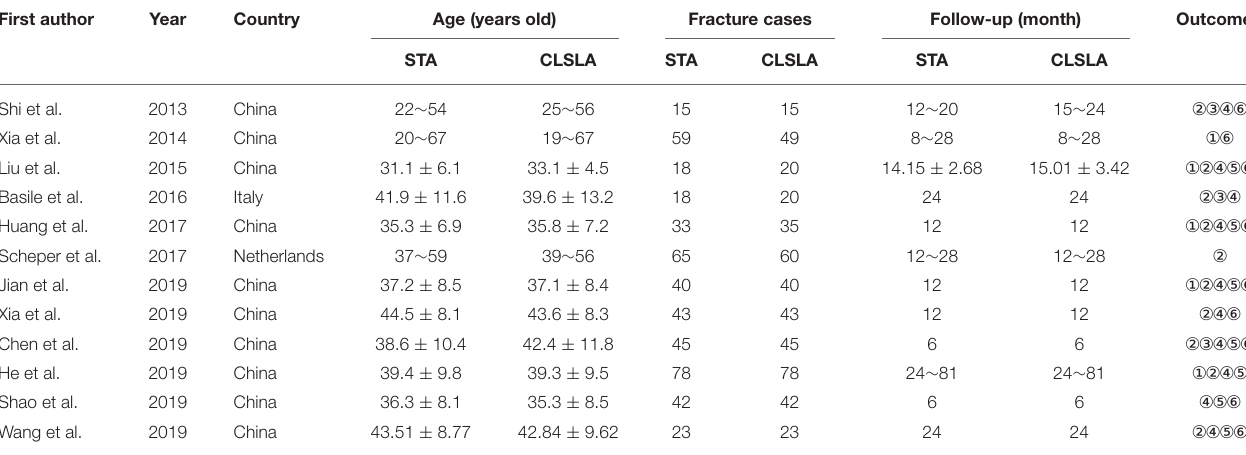
TABLE 1 | General situation and baseline characteristics of the included